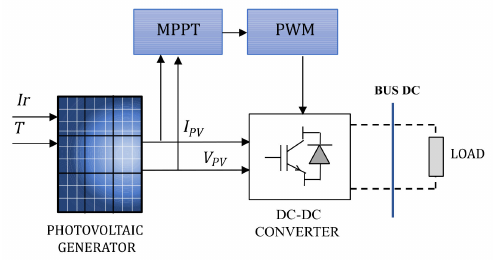
Figure 4. MPPT control for PV.